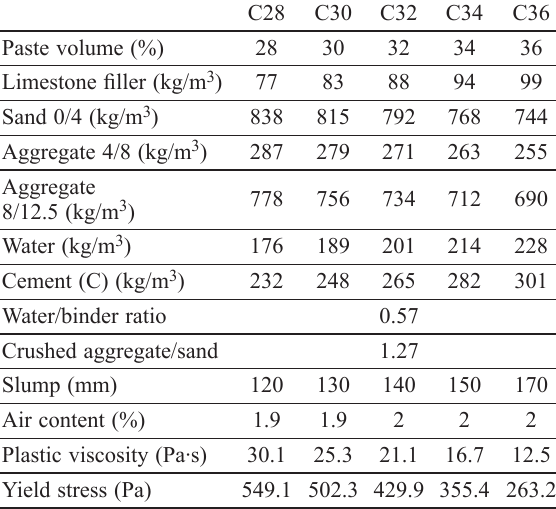
Table 2. Composition and properties of concretes